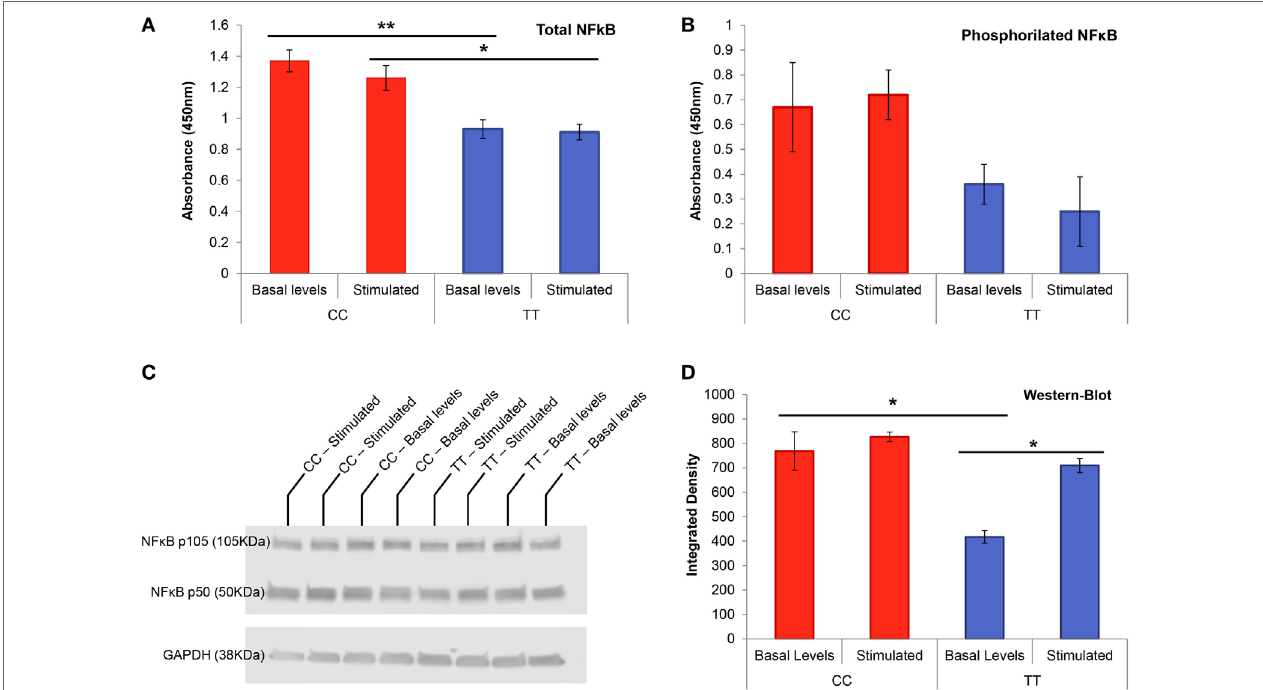
FigUre 4 | NF- κ B transcription factor protein studies in genotype-conditioned lymphoblastoid cell lines (LCLs). (a) Total NF- κ B ELISA performed in homozygous LCL for rs4947296 at basal levels and after stimulation with TWEAK at 250 ng/mL (* p < 0.02, * p < 0.006). (B) Phosphorylation assay for NF- κ B p65 on serine 536 in homozygous LCL at basal levels and after stimulation with TWEAK at 250 ng/mL. (c) Representative NF- κ B western blot of homozygous LCL before and after treatment with 250 ng/mL of TWEAK. (D) NF- κ B western blot showing significant differences between both genotype cells at basal levels as well as differences within the protective genotype cells before and after stimulation (* p < 0.05). CC, risk genotype; TT, protective